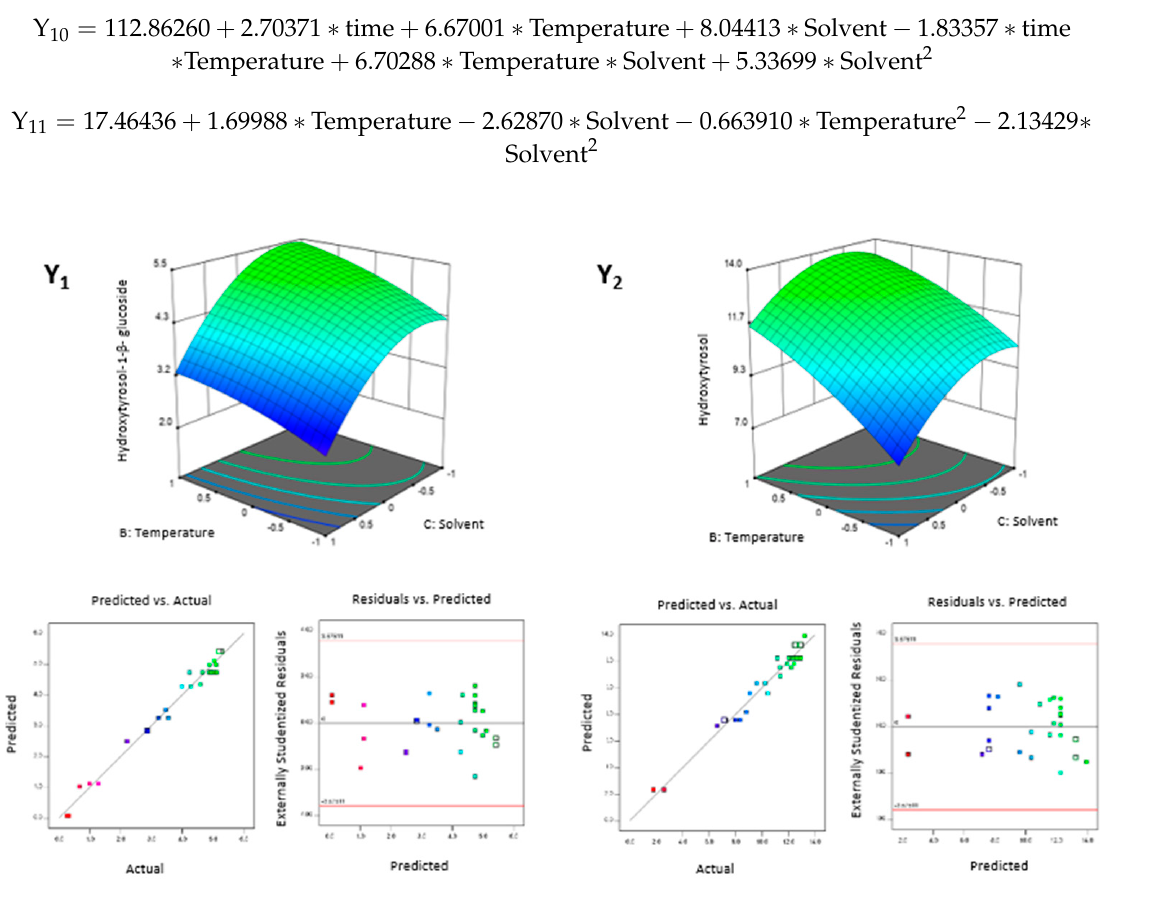
Figure 1. RSM graphs from the eleven responses with statistical diagnostic representations. Each graph displays temperature vs solvent factors, with a time factor adjusted to 0, along with two statistical diagnostics attached. On the top, the graphical representation of the adjustment between predicted vs actual points, and underneath, the graphical representation of residuals vs predicted